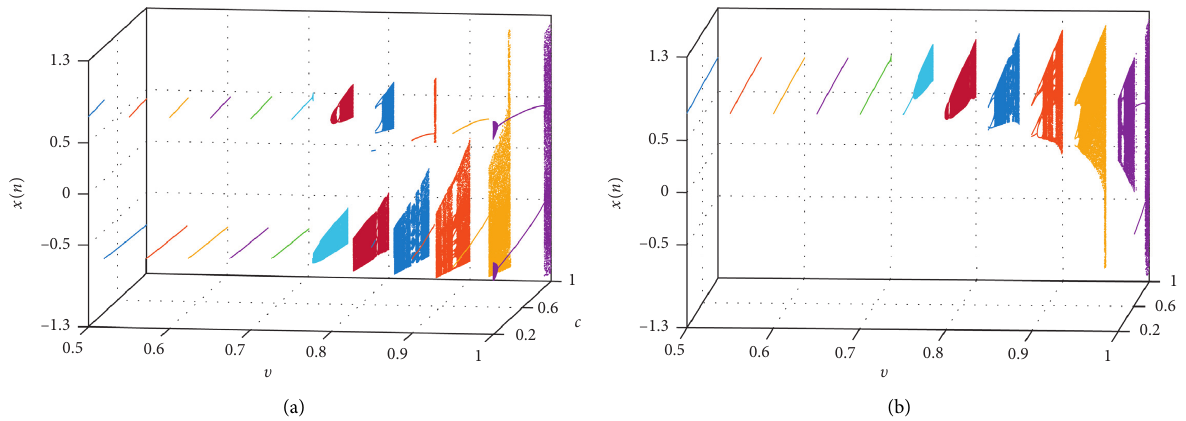
Figure 12: Bifurcation diagrams for map (10) with different initial values as the parameter c and the order υ vary: (a) the bifurcation diagram and (b) the bifurcation diagram with x with x 01